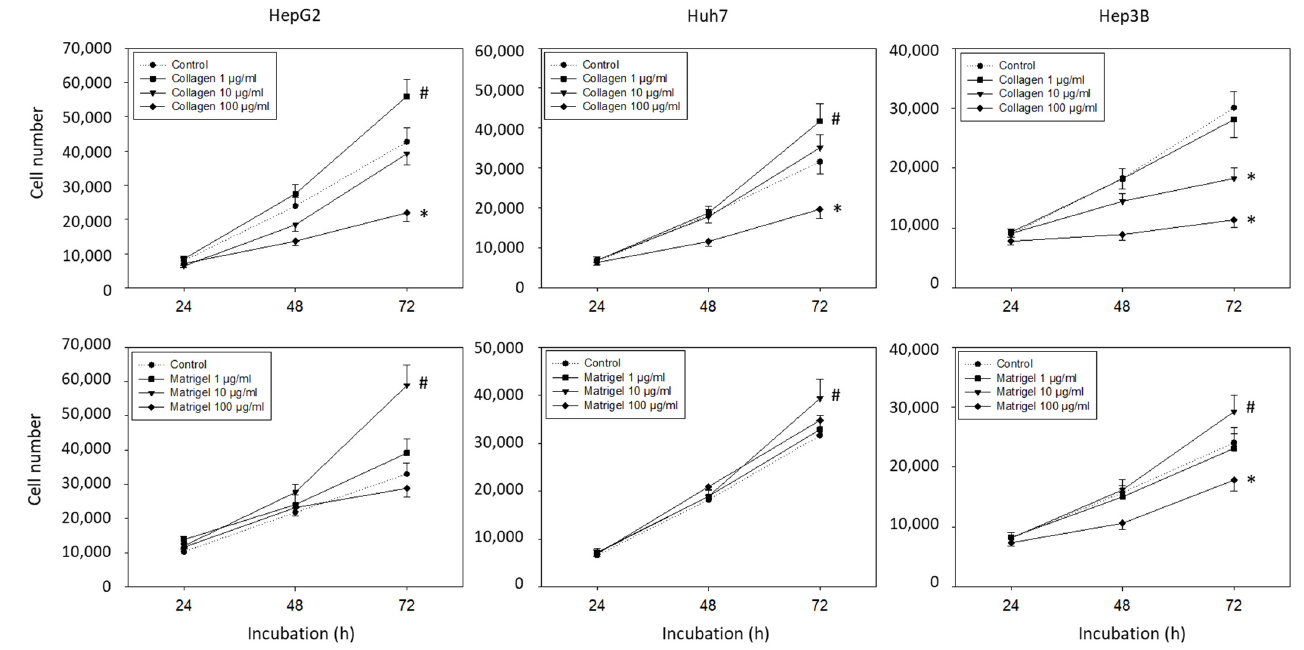
Figure 1. Cell growth evaluation (mean +/ − SD). Hepatocellular carcinoma cell number in response to 0 (control), 1, 10, and 100 µg/mL collagen or Matrigel. MTT analysis was carried out after 24, 48, and 72 h. * significant downregulation, # significant upregulation, each compared to untreated controls ( n = 5).